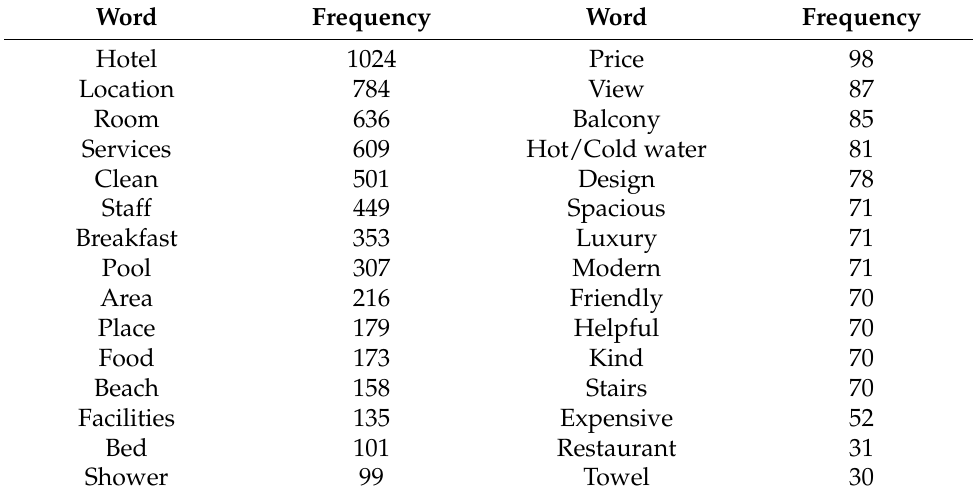
Table 1. Most frequently used words in online reviews.